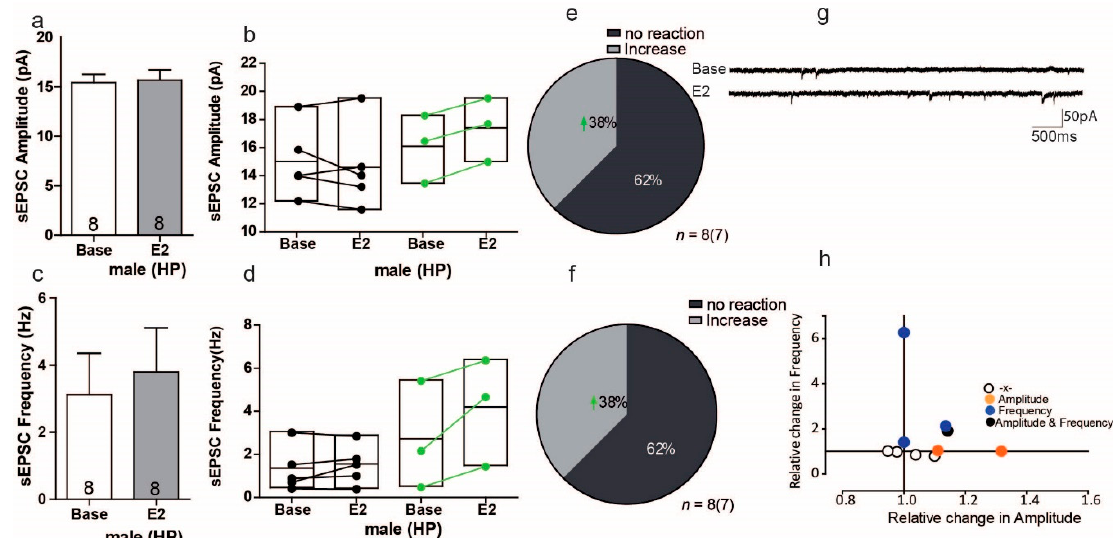
Figure 8. Estradiol enhances sEPSC frequency and amplitude in a subgroup of cells in the hippocampus of male mice. ( a , c ) No significant changes were found in the average sEPSC amplitude and sEPSC frequency recordings during baseline and after E2 treatment. ( b , d ) Within-cell analyses showed that some cells significantly responded to E2 in sEPSC amplitude and sEPSc frequency. ( e , f ) The proportion of cells that responded to E2 treatment in sEPSC amplitude and sEPSC frequency. ( g ) Sample traces, frequencies and amplitudes of sEPSCs before and after DPN treatment. ( h ) No correlations were found between changes in sIPSC frequency and sIPSC amplitude; HP, Hippocampus.